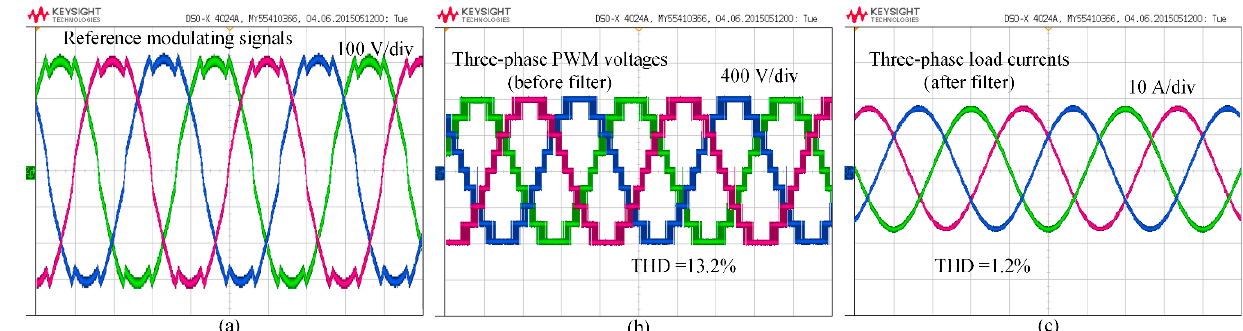
Figure 19. At steady-state condition: ( a ) proposed TSCMPWM modulating signals, ( b ) three-phase line–line PWM voltages before filter, and ( c ) three-phase load currents after filter.